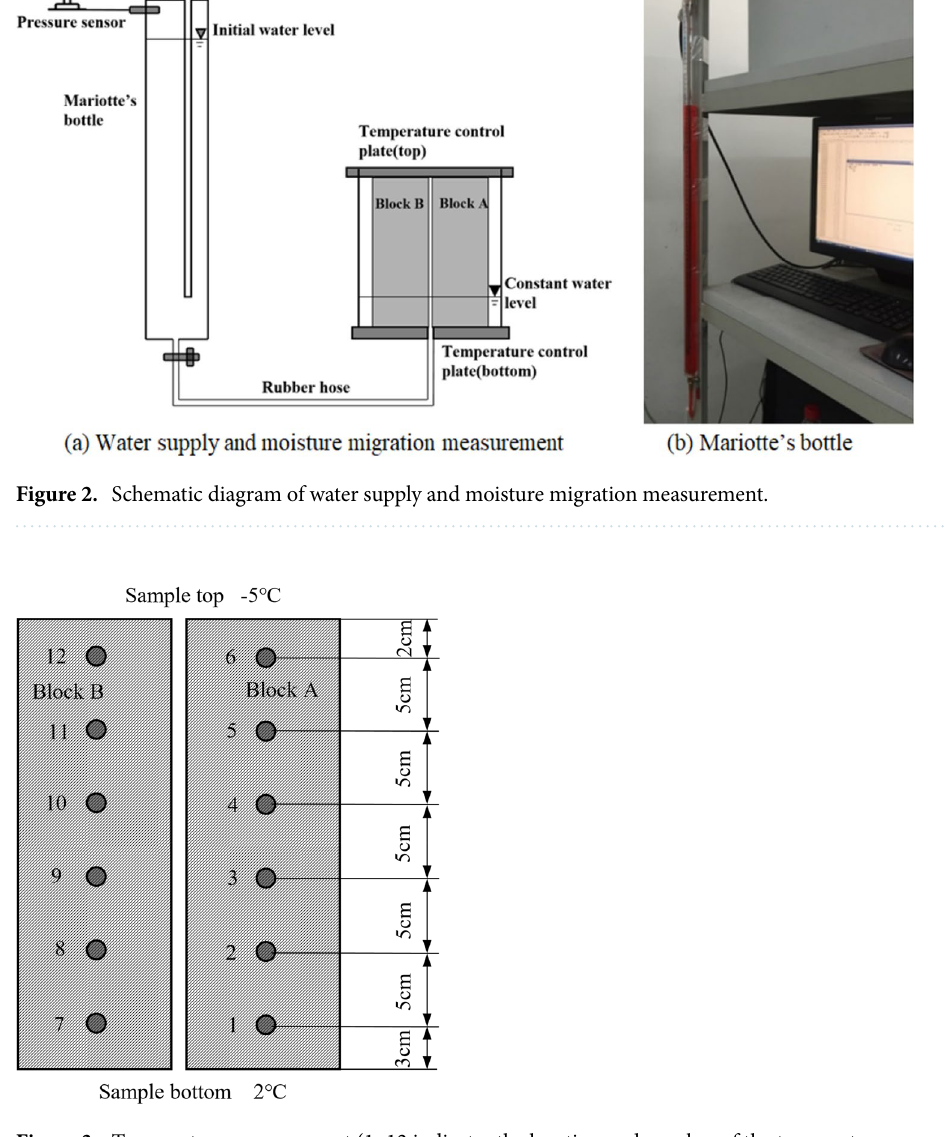
Figure 3. Temperature measurement (1–12 indicates the location and number of the temperature